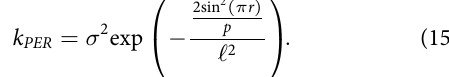
Frontiers in Built Environment |